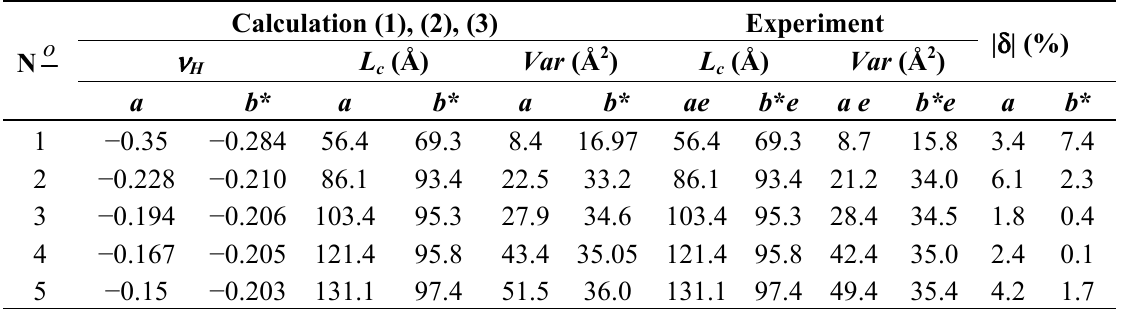
Table 1. Thermomechanical variance of DNA molecule’s length L θ = 1/1.57 = 0.64 rad; ν